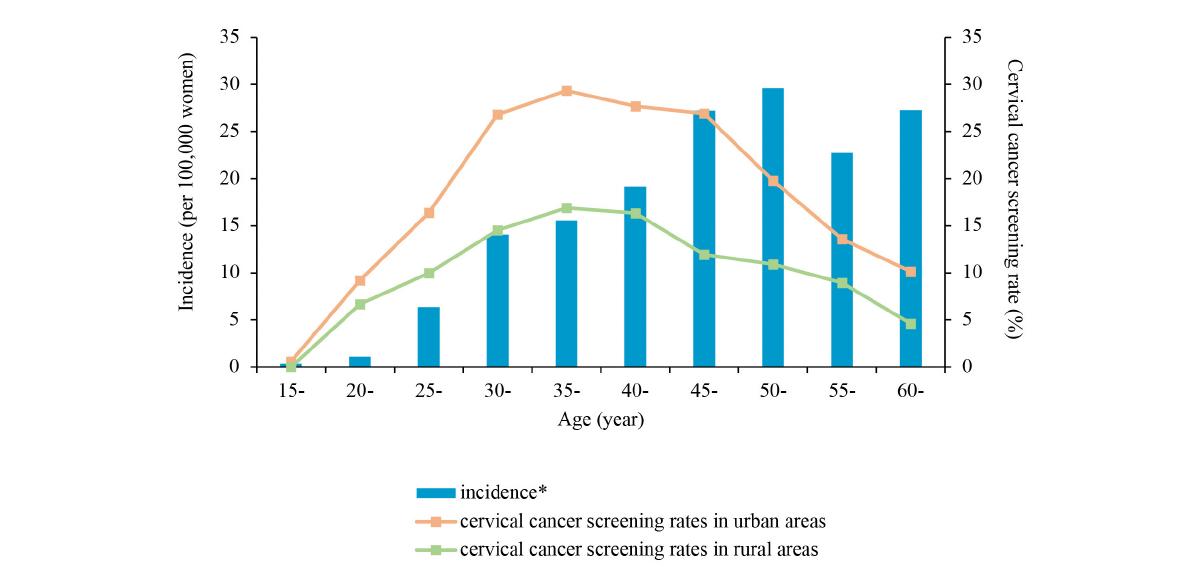
FIGURE1 Incidence of cervical cancer reported by the Global Burden of Disease Study 2017 and the 2013 and 2018 total cervical cancer screening rate in Jilin Province of China by age groups and urban-rural areas. *The data of cervical cancer incidence reported by the Global Burden of Disease Study 2017